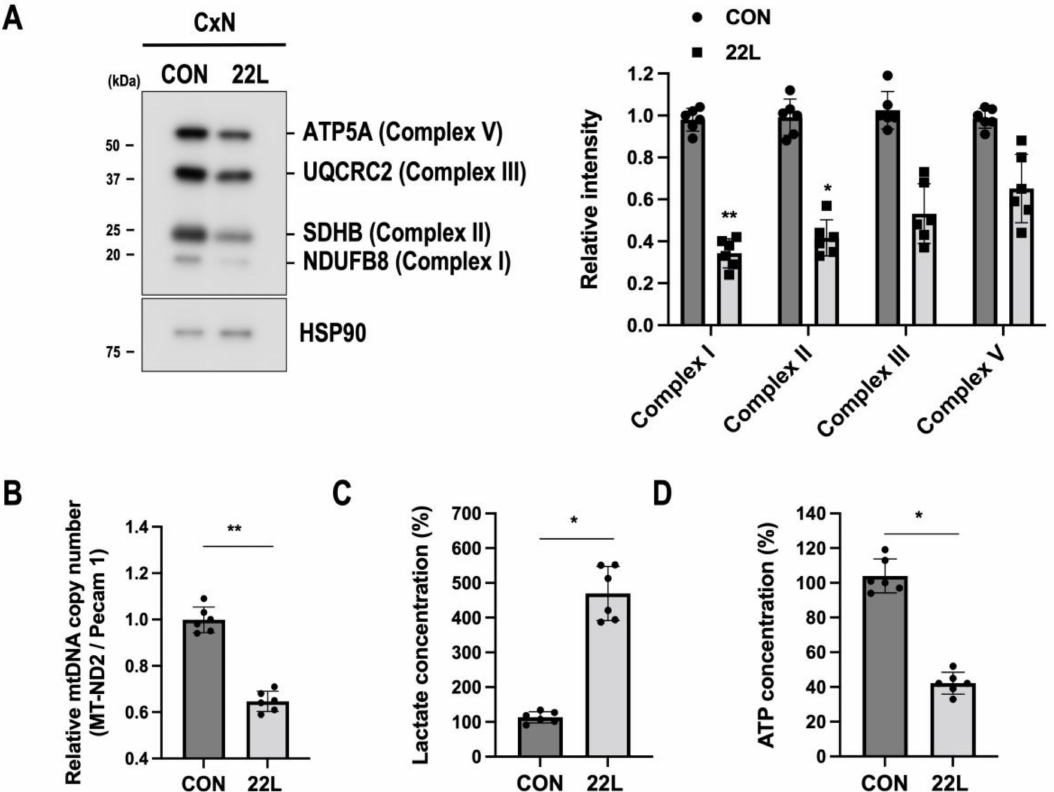
Figure 4. Scrapie infection induces mitochondrial dysfunction associated with defects in OXPHOS- mediated glycolytic metabolism. ( A ) Expression levels of OXPHOS proteins (NDUFB8, SDHB, UQCRC2, ATP5A) in control (CON) and 22L scrapie-infected CxN (22L) cells at 21 dpi were evaluated by Western blot analysis. The intensities of the bands were measured and quantified for each group ( n = 6, ** p < 0.01, * p < 0.05; two-sided Student’s t -test). ( B ) Quantification of mtDNA copy number by qRT-PCR analysis ( n = 6, ** p < 0.01; two-sided Student’s t -test). ( C , D ) Relative levels of lactate and ATP in control (CON) or 22L scrapie-infected (22L) CxN cells at 21 dpi were evaluated using a Lactate-Glo assay kit and ATP EnzyLight assay kit with a fluorescence reader ( n = 6, * p < 0.05; two-sided Student’s t -test), n = number of independent